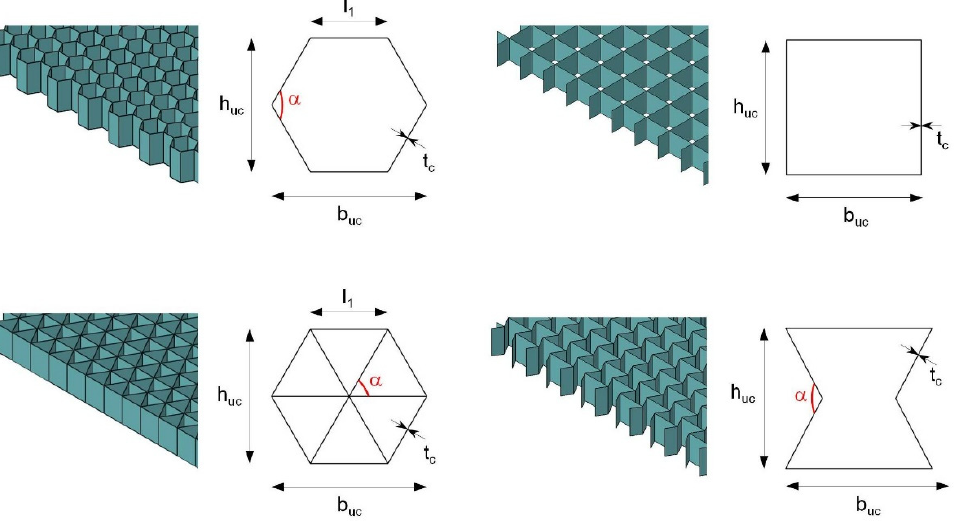
Figure 3. Sections of prismatic closed ‐ cell honeycomb cores with their respective unit cells.